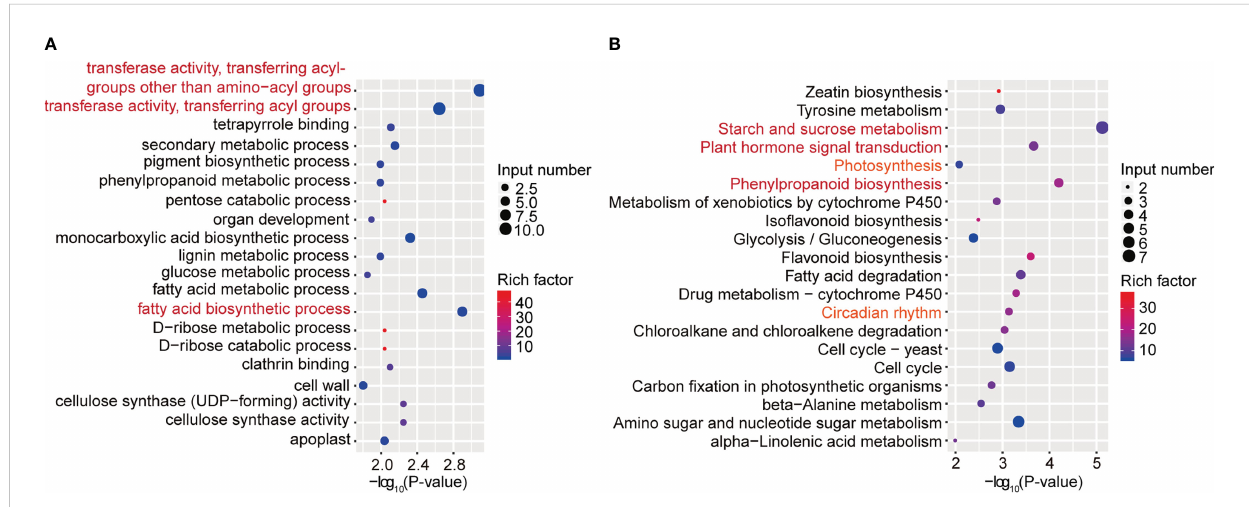
FIGURE 5 GO and KEGG pathway analyses of differentially expressed genes with differential m 6 A peaks. (A) The top 20 GO terms among differentially expressed genes with differentially m 6 A peaks. (B) The top 20 KEGG pathways among differentially expressed genes with differentially m 6 A